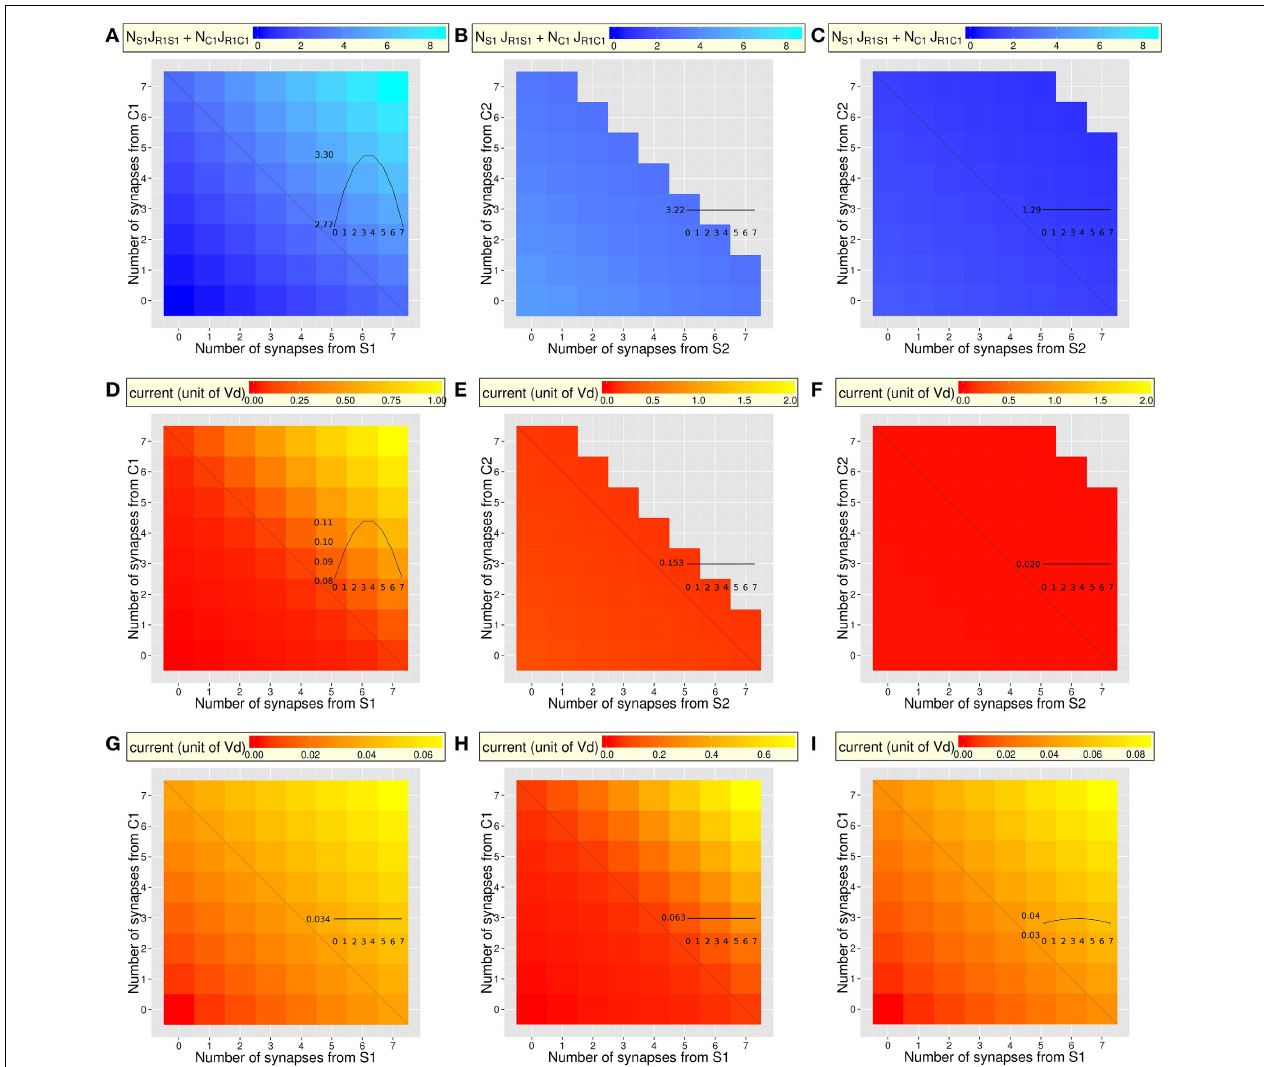
FIGURE 3 | Selectivity and responsiveness of the different types of dendrites to the combined activity of the context and stimulus (same dendrites as in Figure 2). Insets display the total synaptic input or dendritic current along the anti-diagonal of each figure (see Figure 2 ). (A–C) Total pre-synaptic input, as the sum of two efficacies weighted by their number ( n S J R 1 − S + n C J R 1 − C ). (A) Amplification of the total synaptic input increases with amplification of potentiation and with the number of synapses (mean = 3.40; min = 0; max = 8.55). Along the anti-diagonal, synaptic input varies with the ratio of numbers of synapses from C2 and S2, even though the number of synapses is constant. (B,C) . Overall synaptic input is stronger in [C1 = 4, S1 = 4, C2, S2, R1, R2] dendrites ( B; mean = 3.58; min = 3.05; max = 4.69) than in [C1 = 2, S1 = 2, C2, S2, R1, R2] dendrites ( C; mean = 1.34; min = 0.84; max = 2.16). In both cases, synaptic depression decreases efficacy with the increasing number of synapses from C2 and S2 that generate depression of the C1R1 and S1R1 synapses when learning of a C2S2R1 combination. (D–I) Total dendritic current I D generated by a spike train of 20Hz on synapses from neurons coding for the context and stimulus S1 and S2 (averaged over a 100ms stimulation). (D–F) Non-linear integration following IS learning (same dendritic types as A-C). (D) Currents greatly increase with the number of potentiated synapses from C1 and S1 (mean = 0.238; min = 0; max = 1.03). The non-linear responses of dendrites magnify the effect of the efficacy (compare with Figure 2D ). Dendritic currents also vary along the anti-diagonal for a constant number of synapses. (E,F) Two